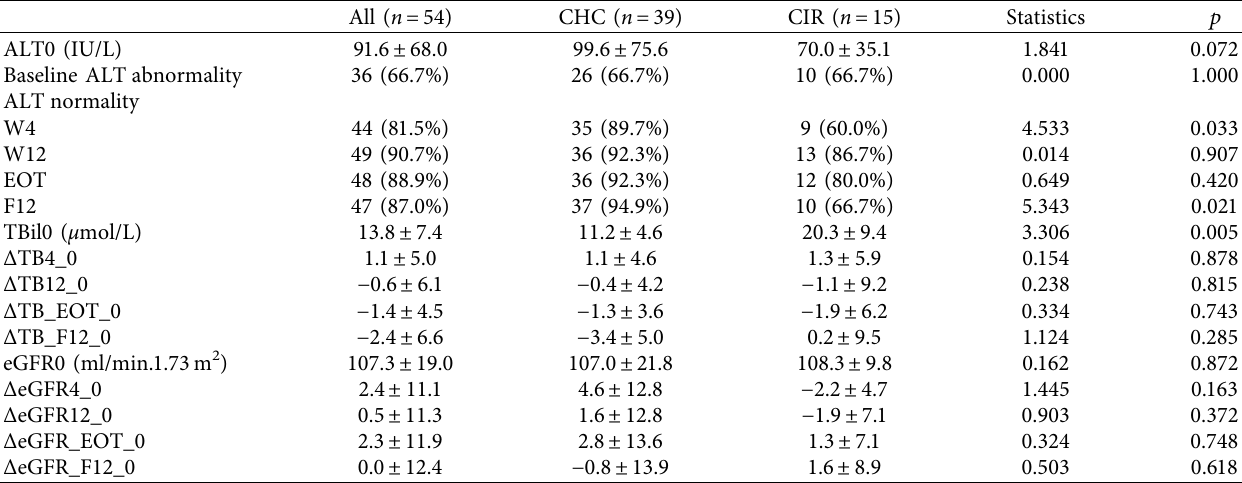
Table 3: The biochemical response of DAAs